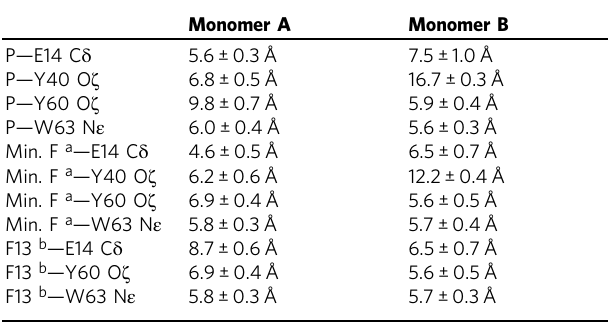
The average distances and standard deviations are from the ensemble of 10 lowest-violation structures in the fi nal 170 ns of the two MD trajectories. a Distances of the nearest fl uorine to protein atoms. b Distances from the F13 atom, which resides in an aromatic box formed by W63 and Y60, to protein